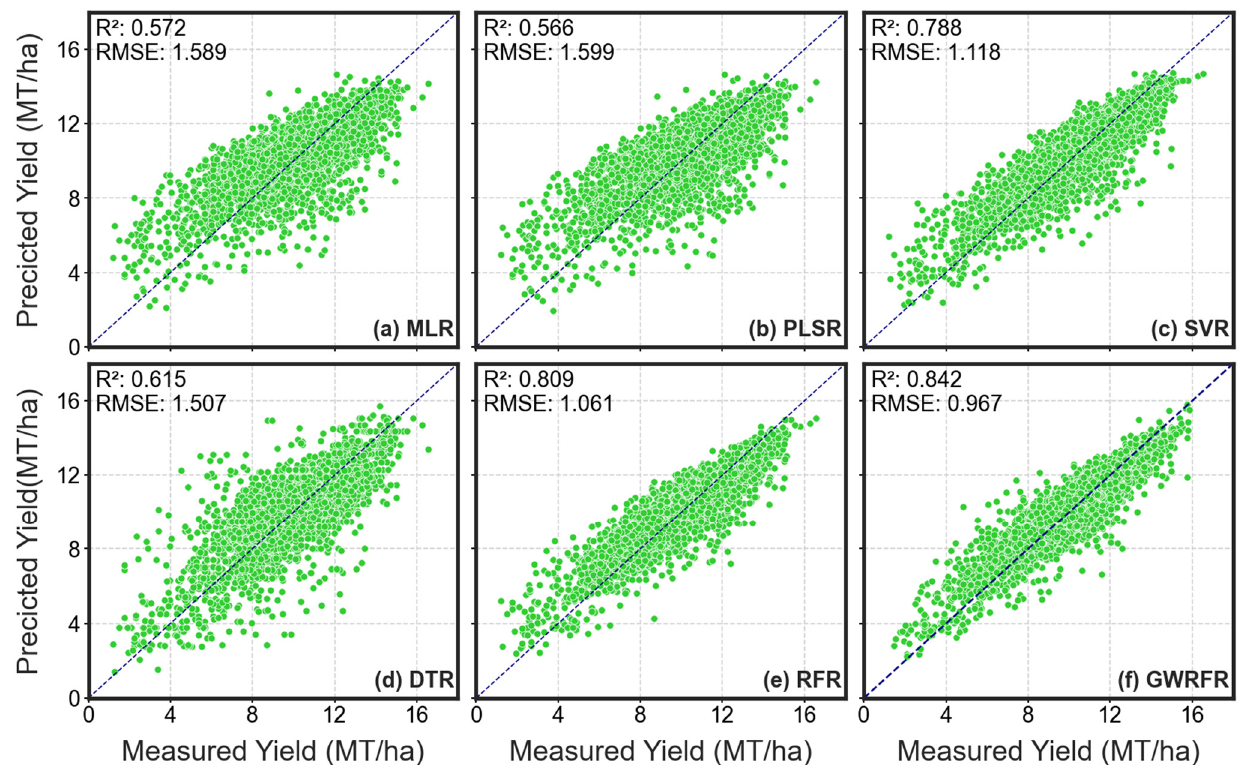
Figure 8. The scatterplots of actual yield and predicted yield derived from ( a ) MLR, ( b ) PLSR, ( c ) SVR, ( d ) DTR, ( e ) RFR, and ( f ) GWRFR using only climate data.